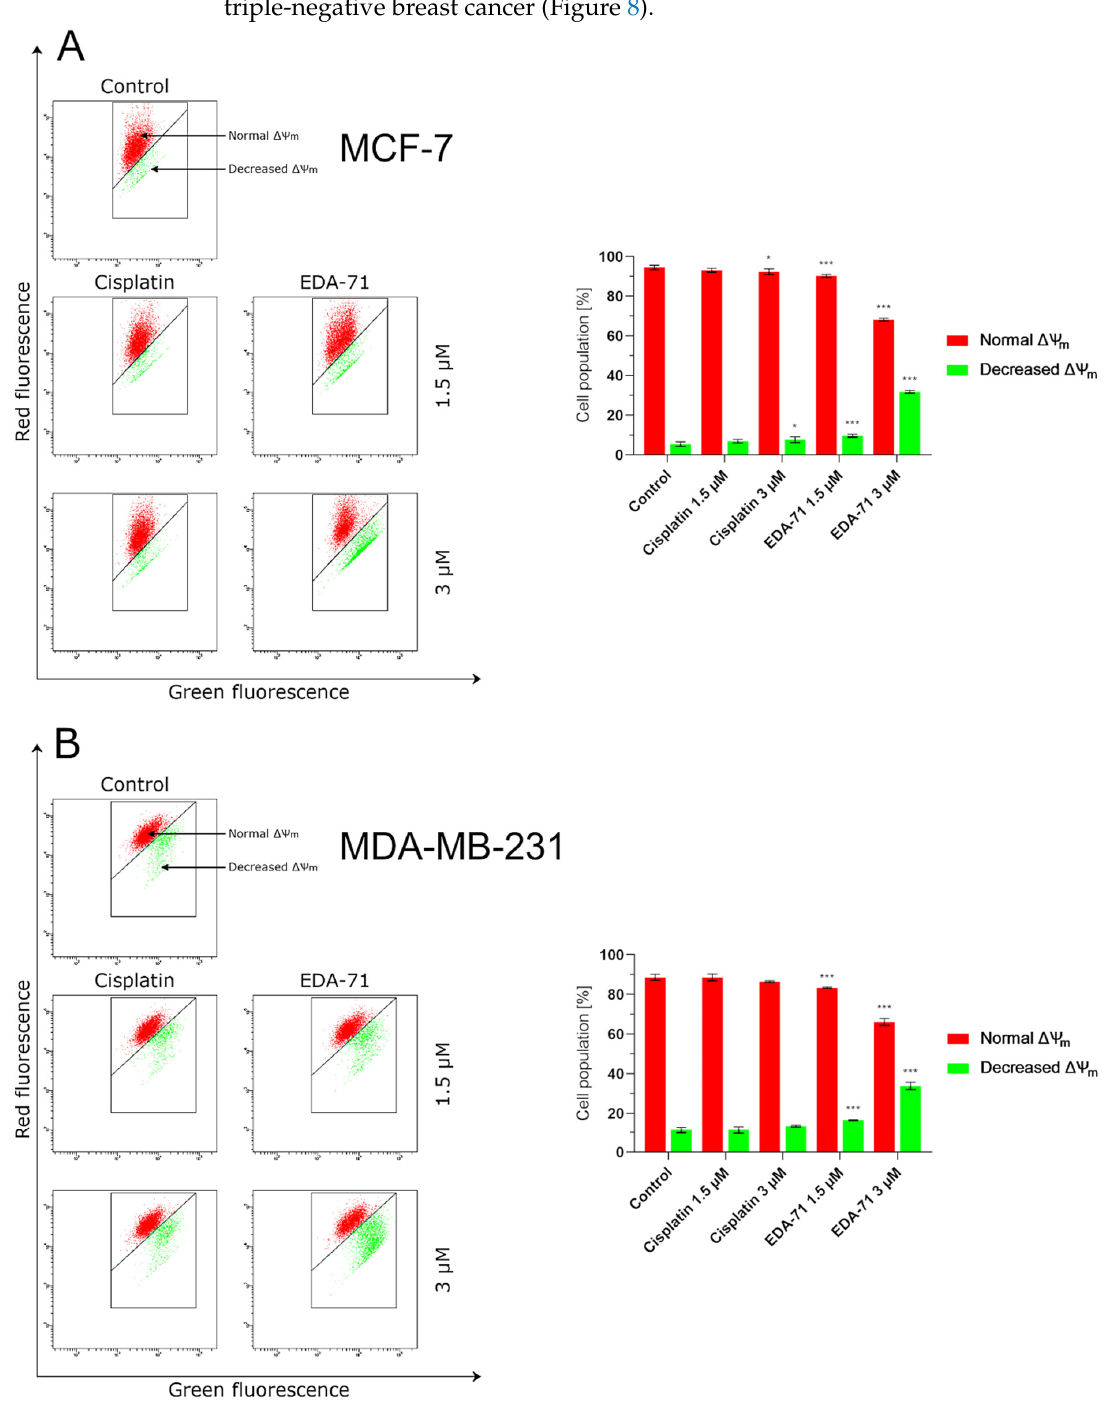
Figure 7. Cytometric analysis of mitochondrial membrane potential (MMP, ∆Ψ m ) changes in MCF-7 ( A ) and MDA-MB-231 ( B ) breast cancer cells after 24 h incubation with EDA-71 and cisplatin (1.5 and 3 µM). Results are presented as mean values ± SD obtained from three independent experiments ( n = 3) conducted in triplicate. Statistical differences between the experimental (treated cells) and control (untreated cells) groups were determined using one-way ANOVA followed by Dunnett’s test. * p < 0.05 vs. control group, *** p < 0.001 vs. control group. NF- κ B is a protein transcription factor with antiapoptotic activity that is overex- pressed in cancer cells [27]. Its antiapoptotic properties are due to, among other things,